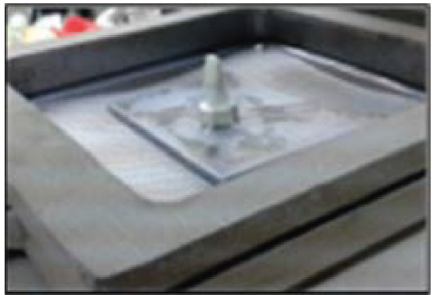
Figure 6: Vacuum formed resin